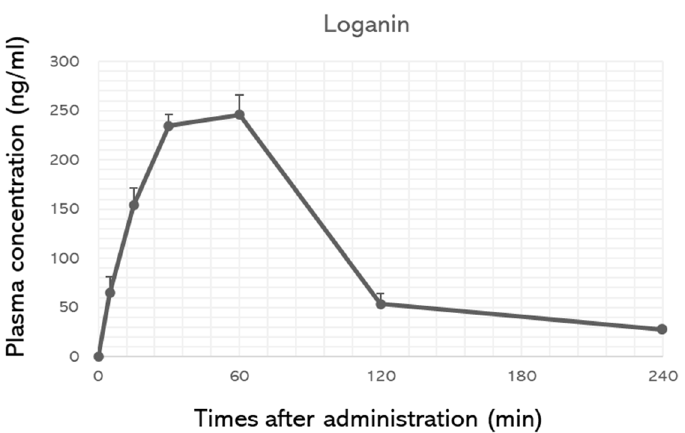
Figure 8. Mean plasma concentration-time curve of loganin in mice after administration of a single dose (5 mg/kg). Data are presented as the mean ± SEM ( n = 3).